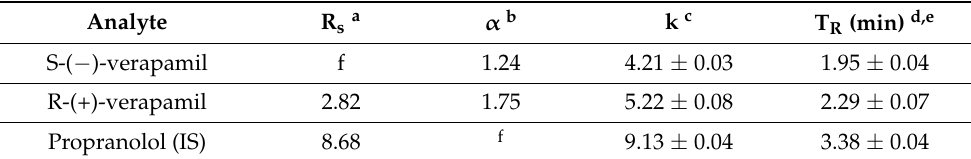
Figure 2. Representative overlaid HPLC chromatograms of the rat plasma analysis of S-( − )-verapamil (1.95 min), R-(+)- verapamil (2.29 min) (1.0–450 ng/mL) and propranolol (3.38), (IS), (500 ng/mL). Table 2. Chromatographic parameters of verapamil enantiomers and internal standard in rat plasma using the proposed